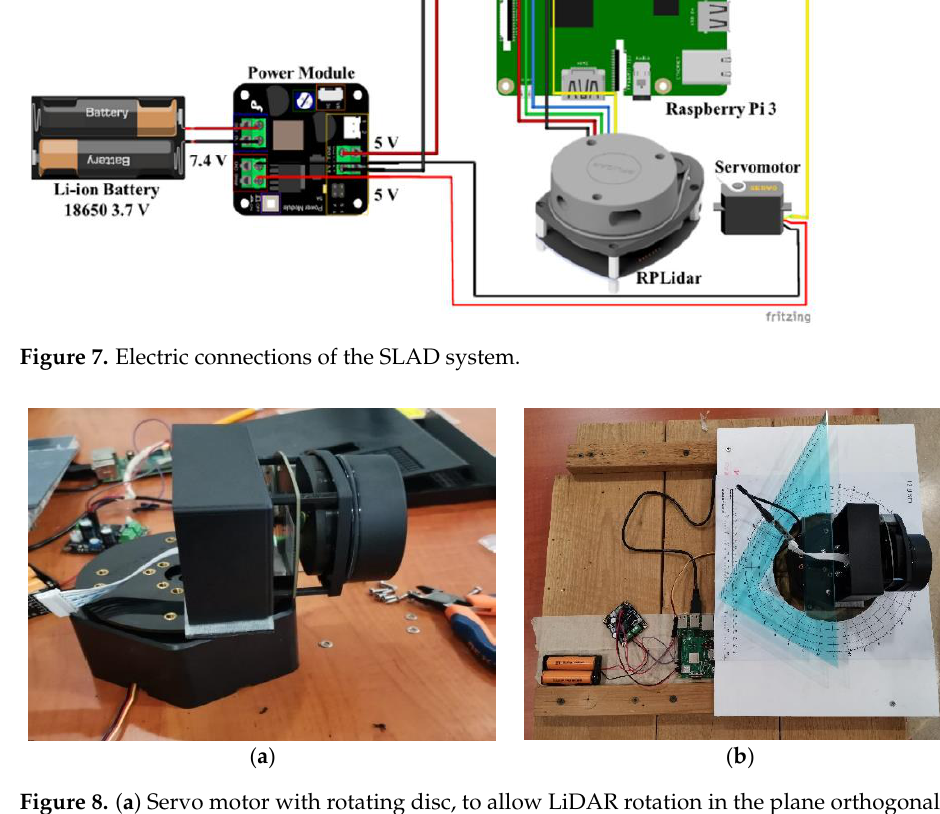
Figure 8. ( a ) Servo motor with rotating disc, to allow LiDAR rotation in the plane orthogonal to the laser rotation axis; ( b ) The prototype with a graduated disc allowing to take readings of the servo motor angular position α